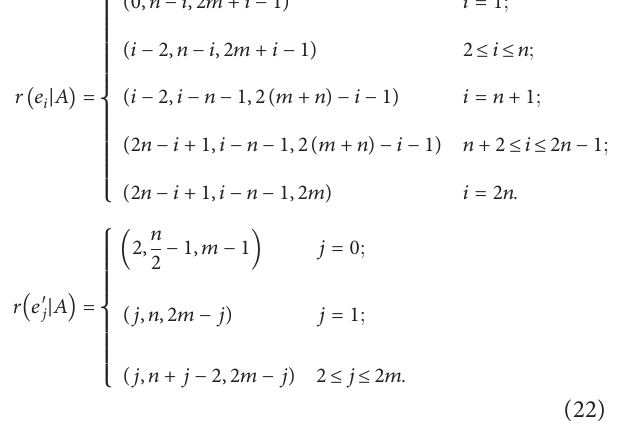
) ; (b) Subdivision graph of dragon graph S ( T 4 , 2